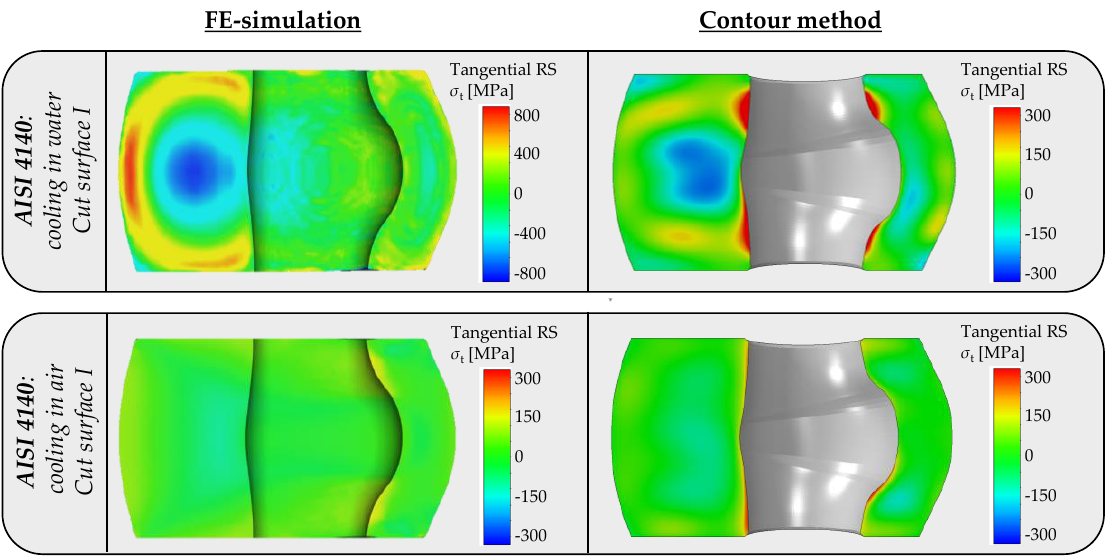
Figure 13. Comparison of the spatial distribution of the tangential RS on the cut surface of AISI 4140 after cooling in water or air from the FE-simulation and the contour method.